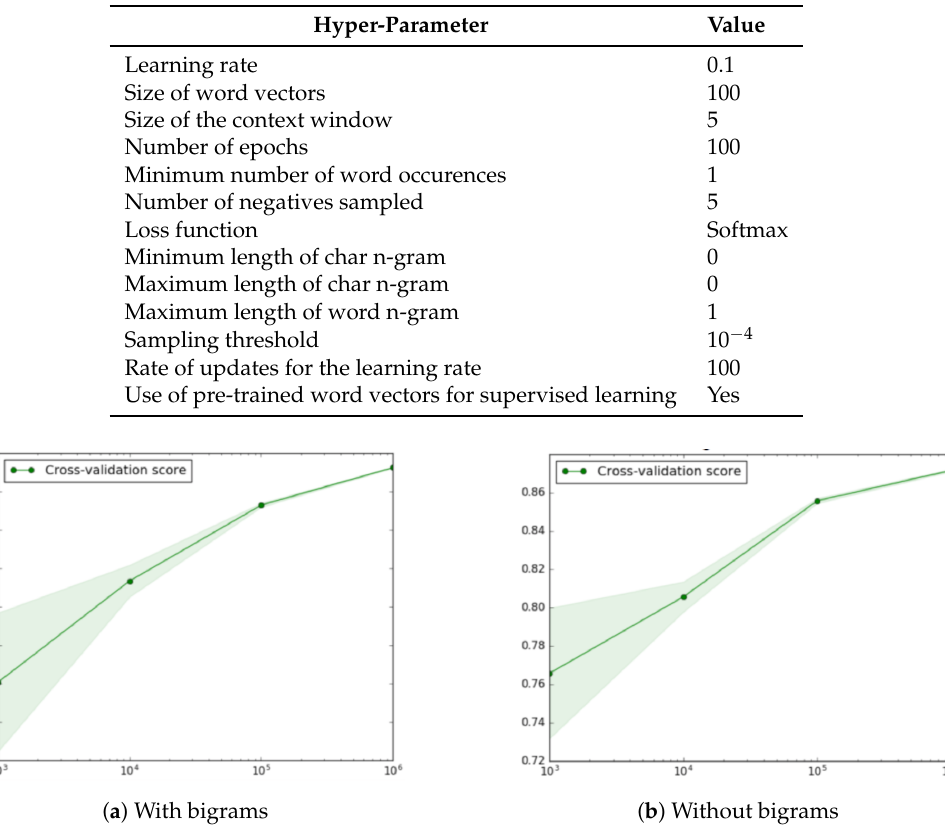
Figure 4. Learning curves with 5-fold cross-validation on the FastText classifier using as input pre-trained word-embeddings learned ( a ) with bigrams and ( b ) without bigrams. The green region represents the standard deviation of the